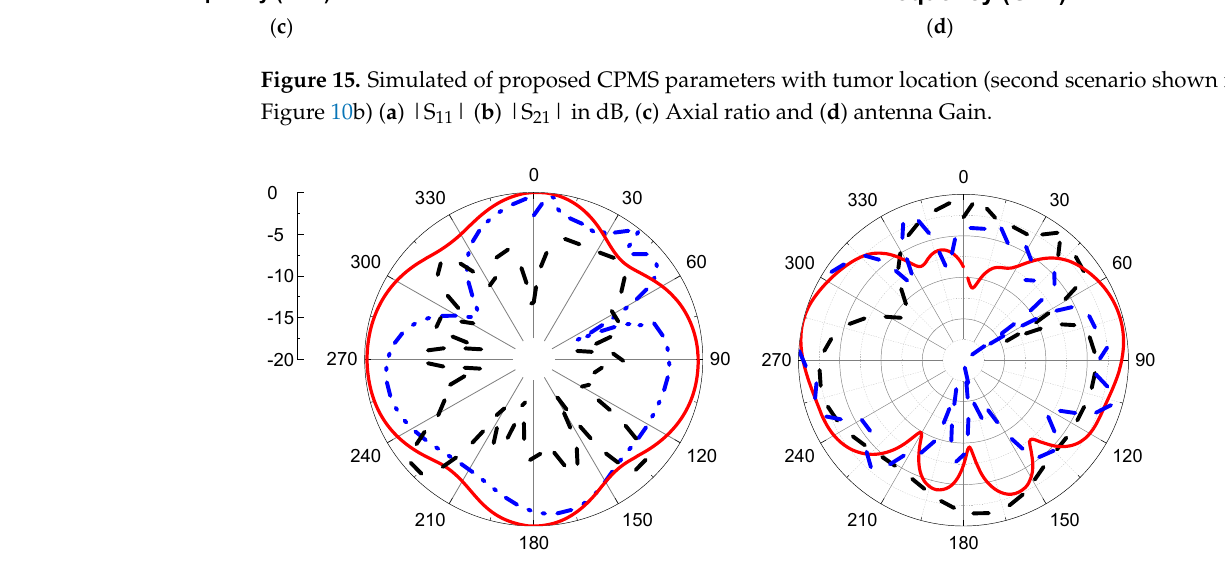
( b ) Figure 17, Radiation pattern for proposed antenna with and without breast model ( a ) φ = 0°, ( b ) φ = 90° Red line: simulated without phantom, black dash line: simulated with phantom, and blue dash ‐ dot line: measured without phantom) at 4.5 GHz. 4. Experimental Results This section will present the fabrication and measurements of the proposed CPMS. Experimental results will be compared with simulations. In Section 4.1, Measurements in air and off ‐ body will be presented. This includes measurements of magnitude and phase for reflection coefficients, transmission coefficients, and gain, as well as an axial ratio ver ‐ sus frequency. Moreover, measurements for the proposed sensor on breast phantoms are performed and analyzed. SAR levels are calculated and presented in Section 4.2. 4.1. Sensor Measurements The proposed microwave sensor antenna is drawn to scale on Wilcon Embroidery Studio software for accurately produced antennas using a computer numerical control (CNC) milling machine and fabricated, as shown in Figure 18a. ShieldiT is used as a con ‐ ductive fabric for the proposed antenna ‐ based sensor. The proposed sensor is stitched to cotton fabric acting as substrate, as shown in Figure 18a. It is further measured using Rohde and Schwarz vector network analyzer with Model no. ZVA67 and bandwidth from 10 MHz up to 67 GHz. The reflection coefficient is recorded and compared with simula ‐ tions in Figure 18b.